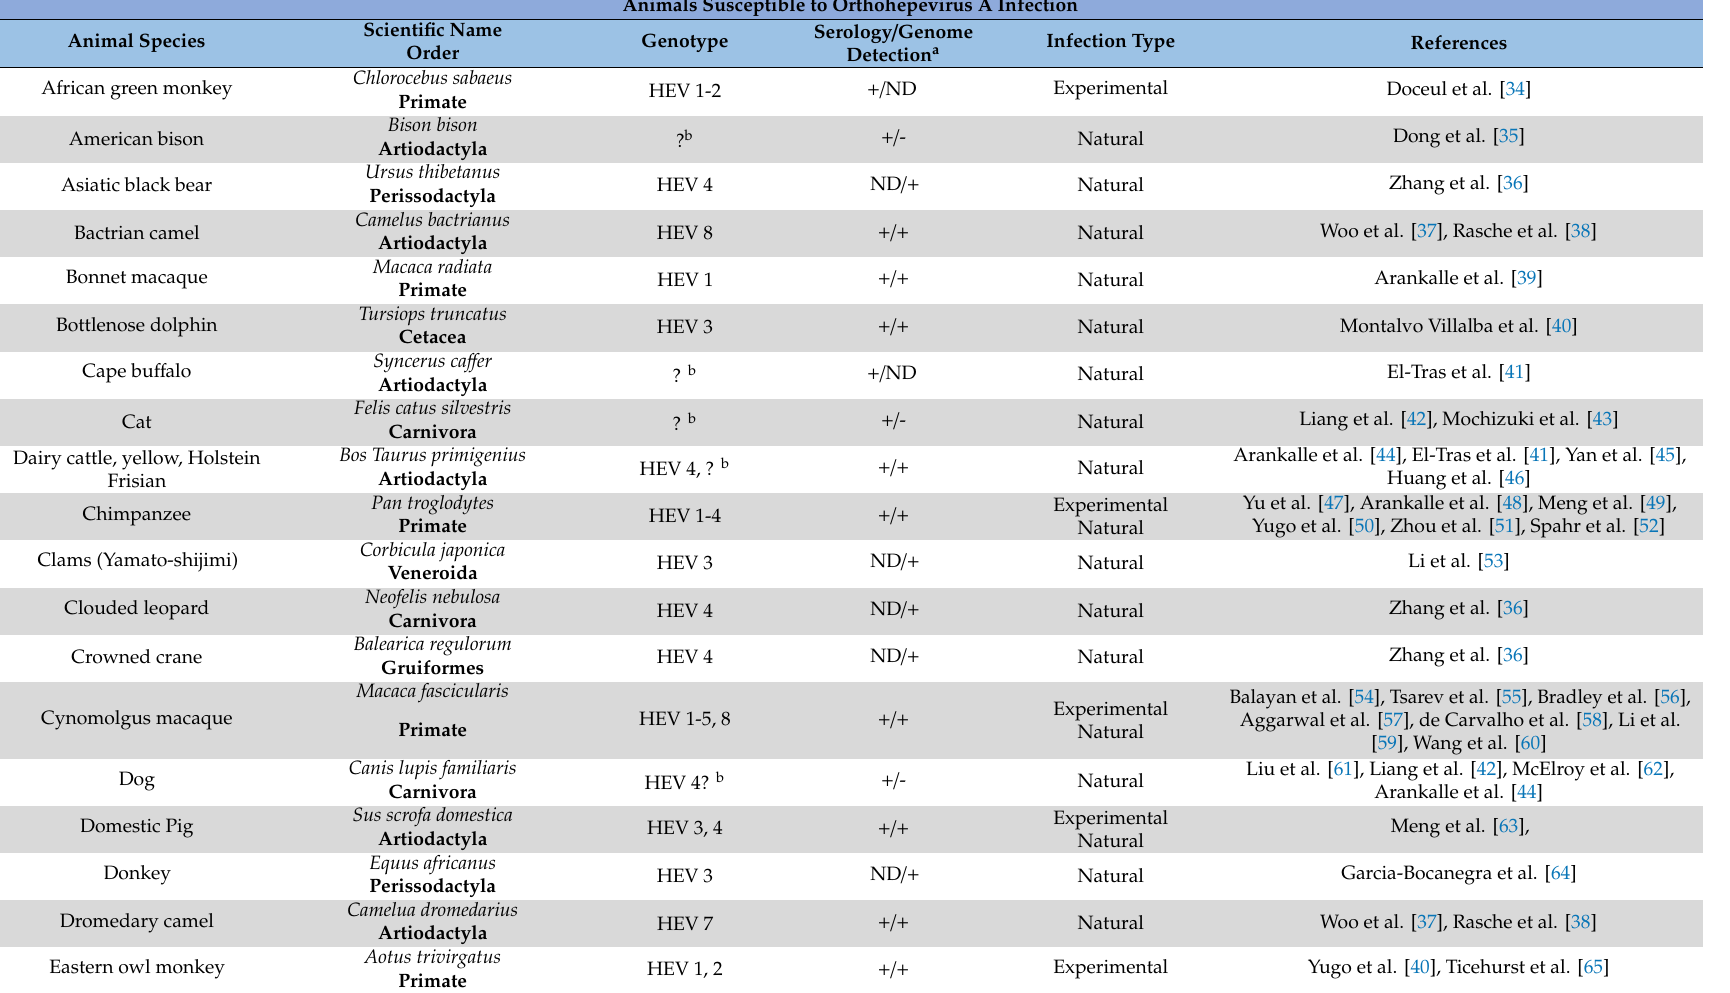
Table 1. Host Range for Orthohepevirus A